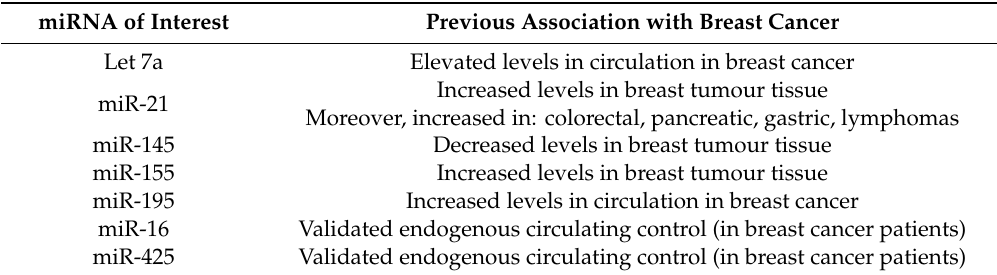
Table 1. Target and control miRNA panel and published association with breast